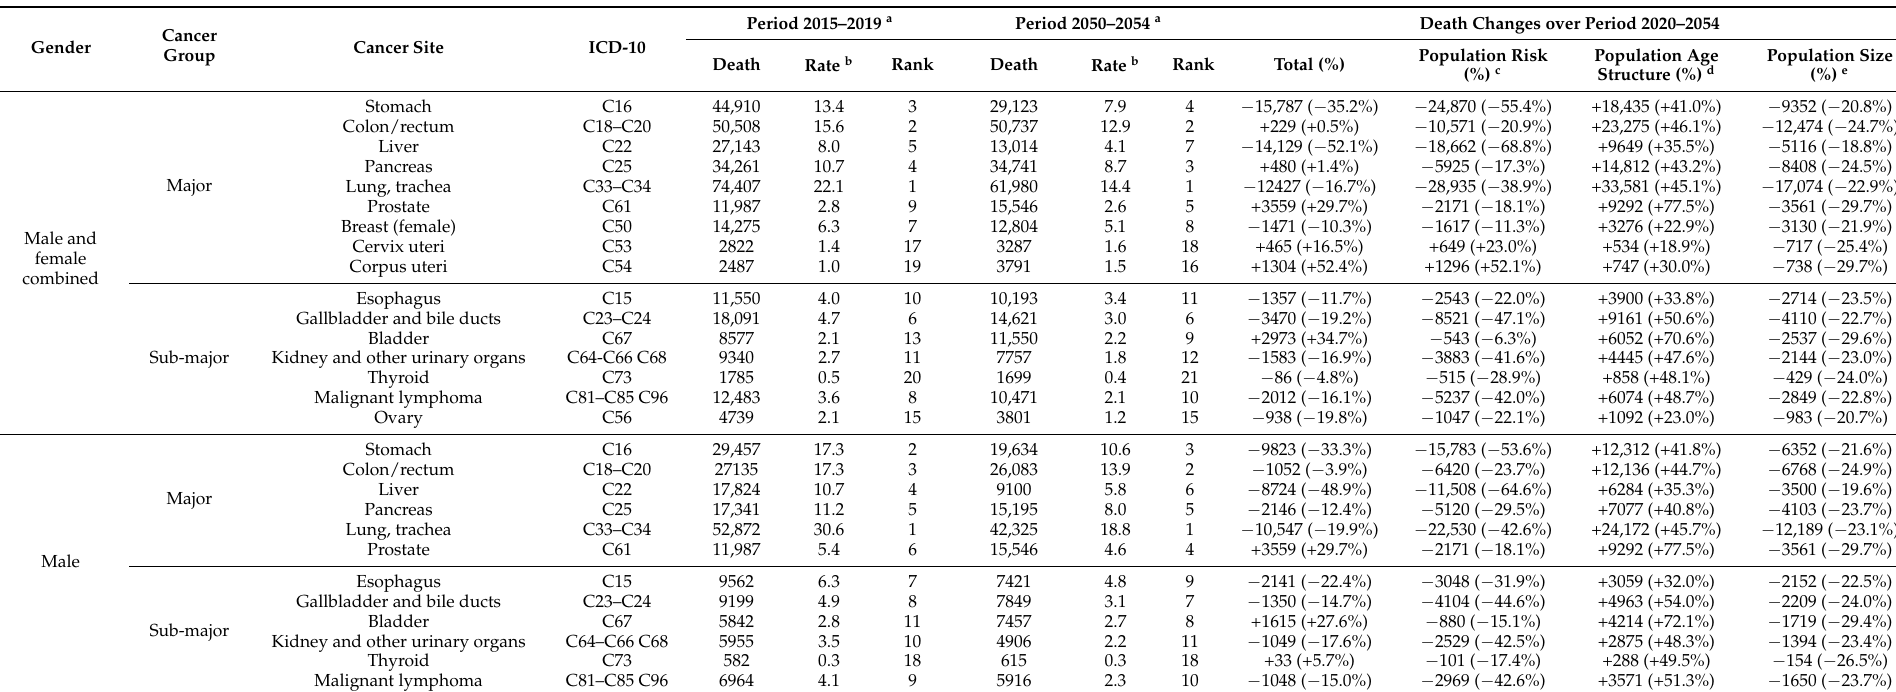
Table 4. Site-specific cancer mortality by gender and decomposition of death changes in 2020–2054 for major and sub-major